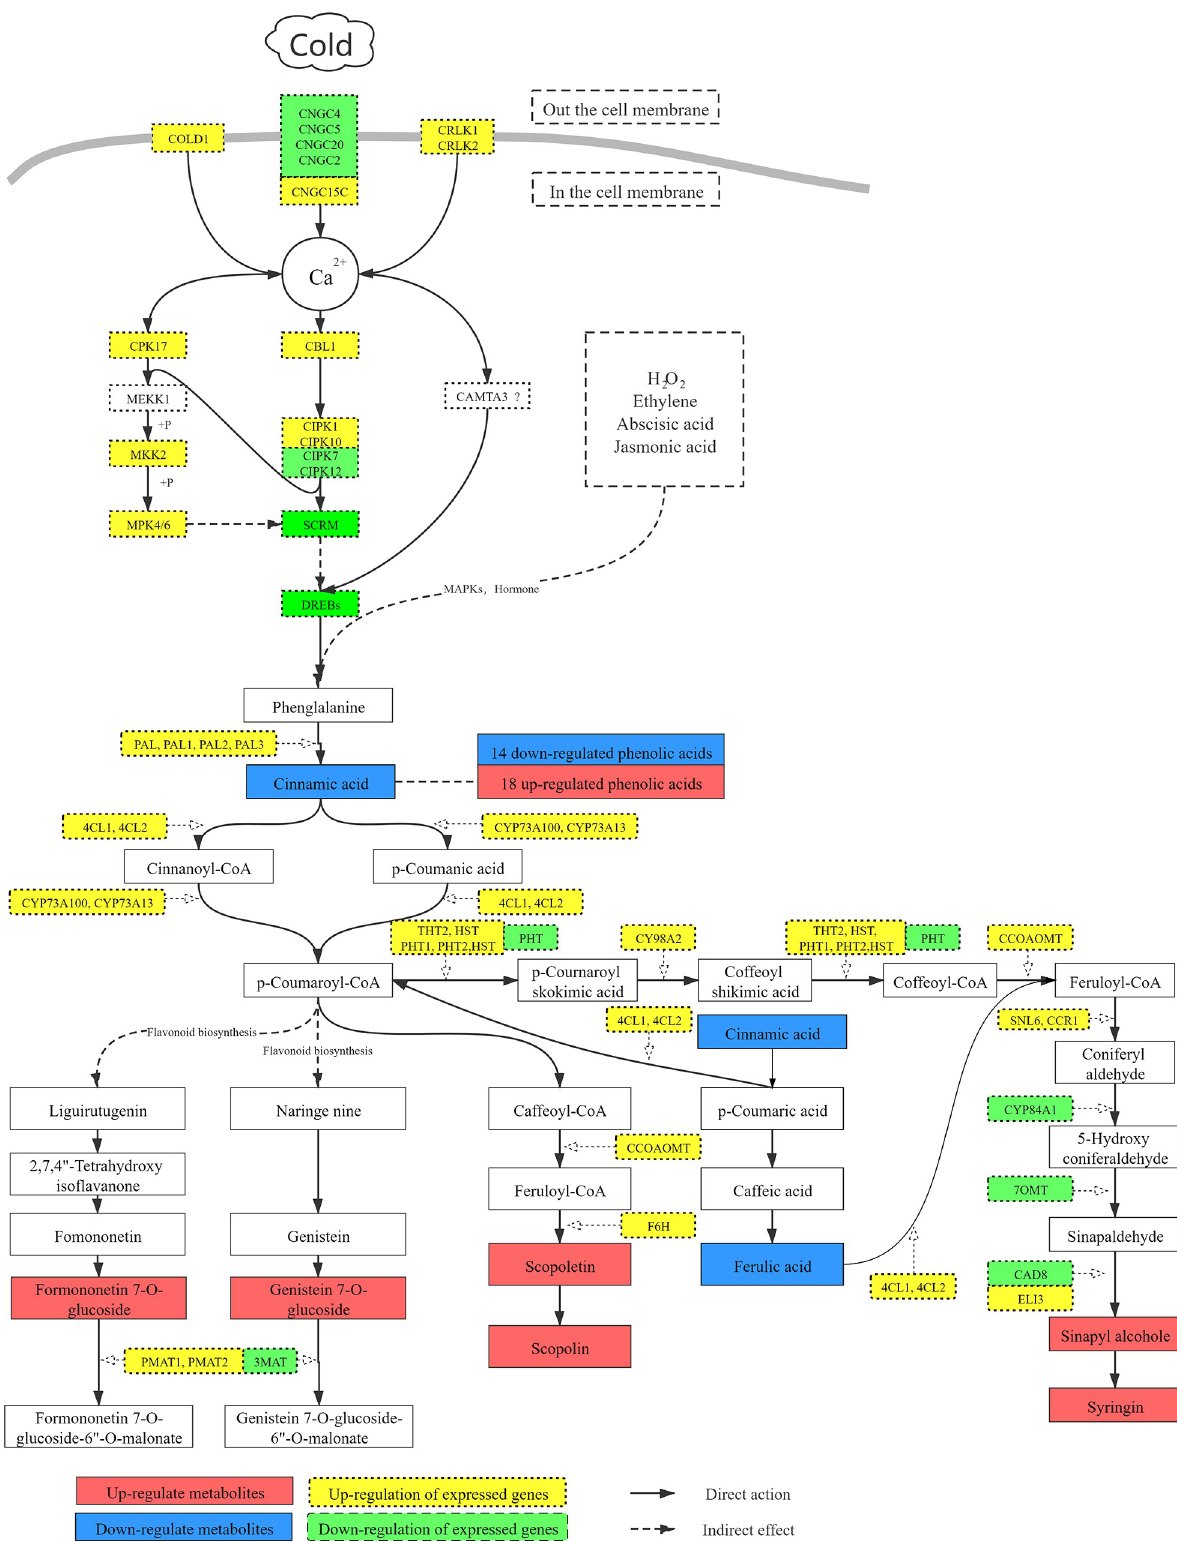
Fig 6. Signal transduction and the pathway of phenylpropanoid synthesis in H . ventricosa .